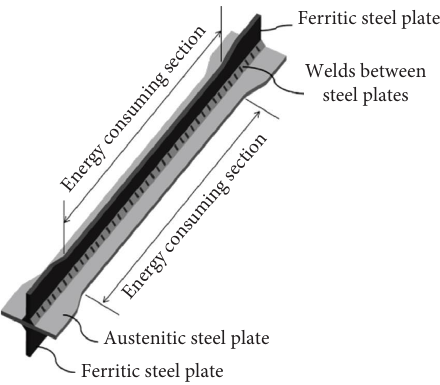
Figure 5: Schematic diagram of double order constraint